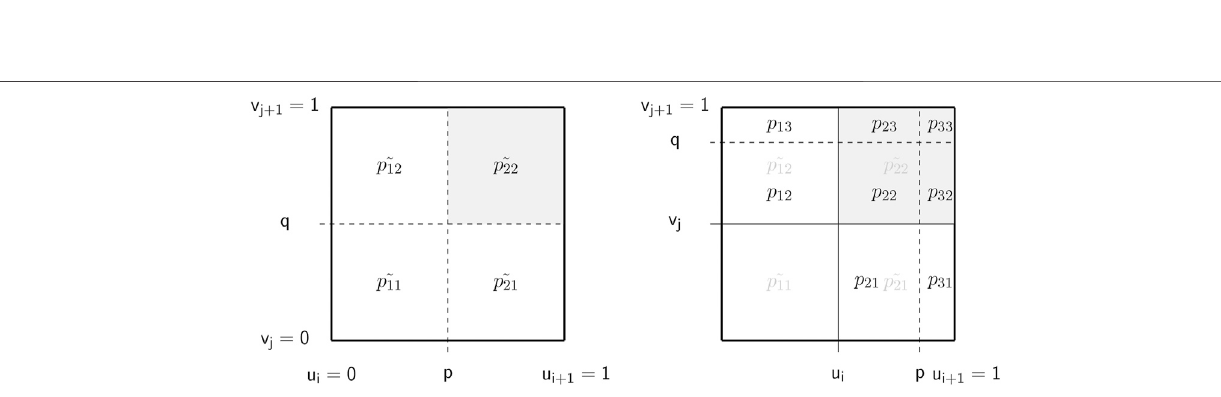
FIGURE 7 | Comparison of maximum times in system (in minutes) for simulation with dependent and independent service times.